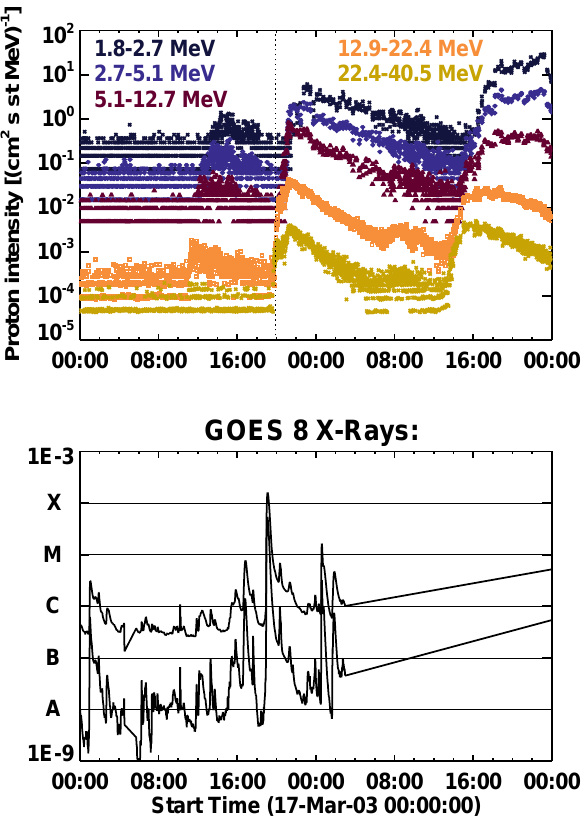
Fig. 7. (top) SEP intensity associated with the 17 March 2003 RQ CME from SOHO/ERNE in 5 energy channels. The CME onset (19:54UT) is marked by the vertical dotted line. The SEP event was preceded and followed by other SEP events, but all are well sepa- rated. (bottom) GOES soft X-ray intensity (in two energy channels: 1–8 A upper, and 0.5–4 lower) as a function of time, showing the X1.5 flare associated with the